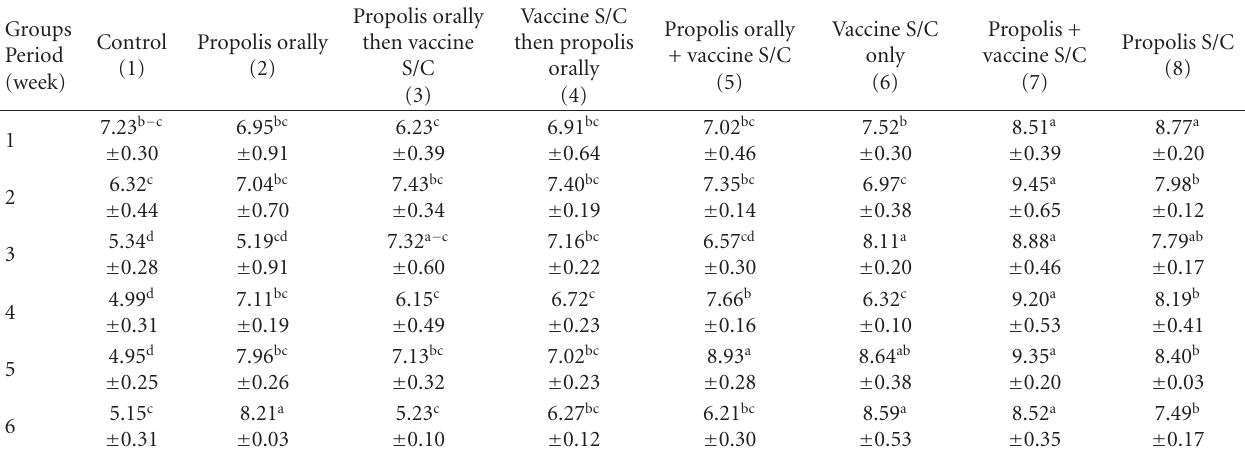
Table 2: Serum total proteins (g/dL) in di ff erent experimental groups of rabbits received propolis and vaccine treatments for six weeks (mean ±